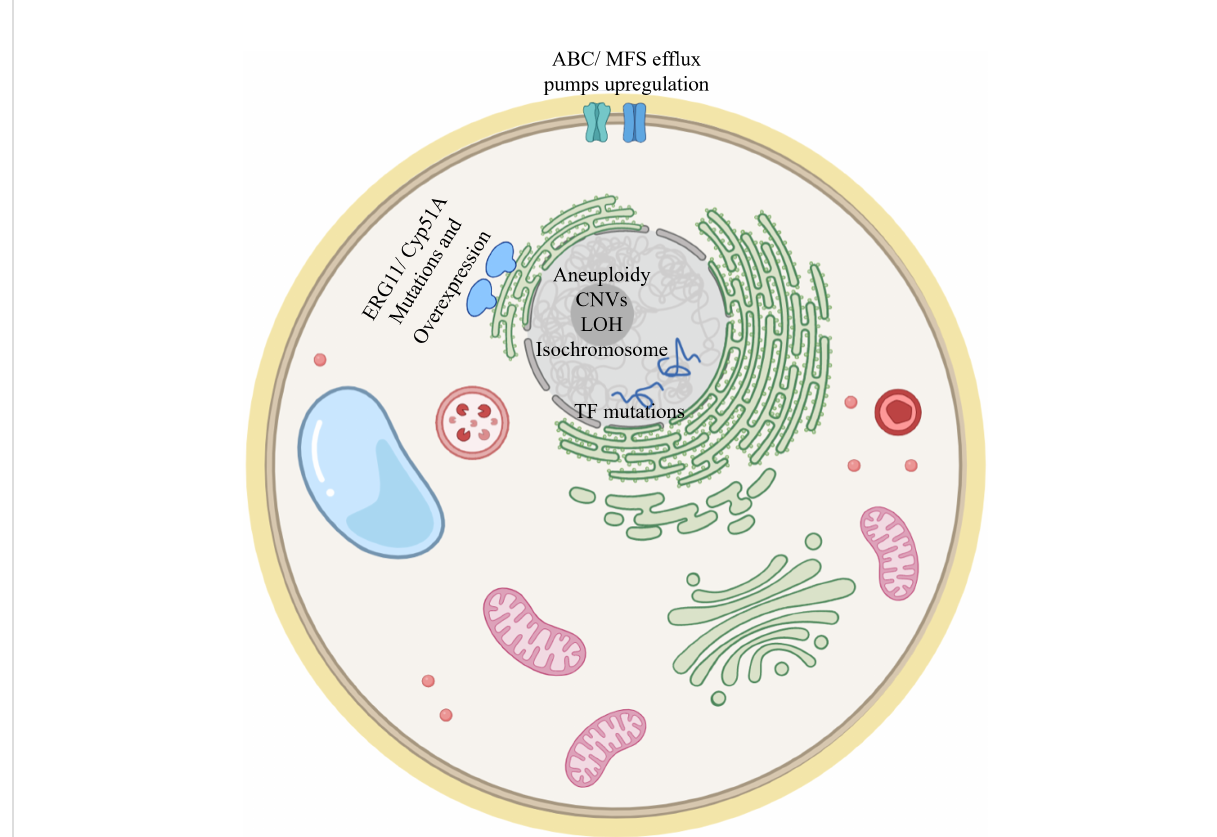
FIGURE 5 Model of a fungal cell showing the main resistance mechanisms described in this review. ERG11/Cyp51A mutation and overexpression have been documented in Candida spp , Cryptococcus spp and A. fumigatus . Upregulation of ef fl ux pumps has also been described in both clinical and experimental evolution studies for the three fungi addressed in this review. Mutations in transcription factors (TFs) modulating ERG11 / cyp51A gene expression have been described. Aneuploidy, CNVs, LOH and isochromosome formation have been documented in Candida spp and Cryptococcus spp